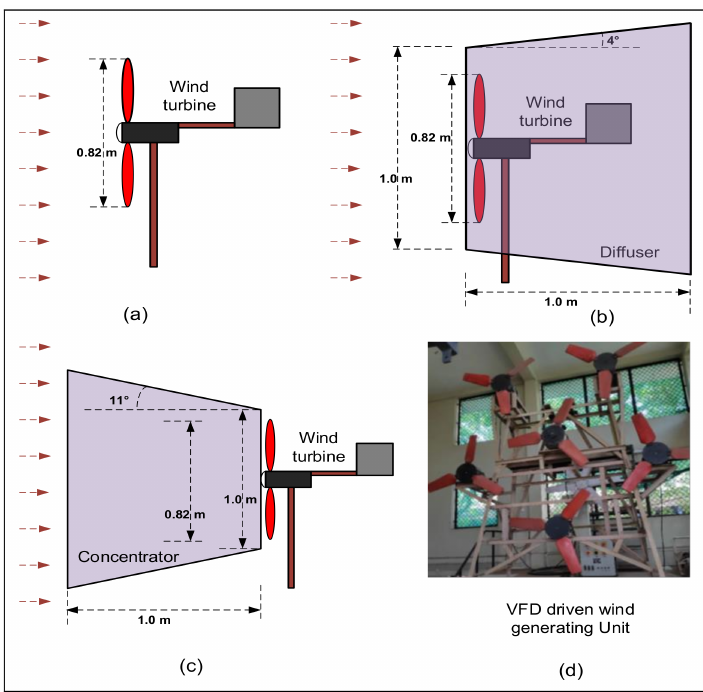
Figure 13. ( a – c ) Dimensional drawings of practical test setup; ( d ) The VFD wind generator.